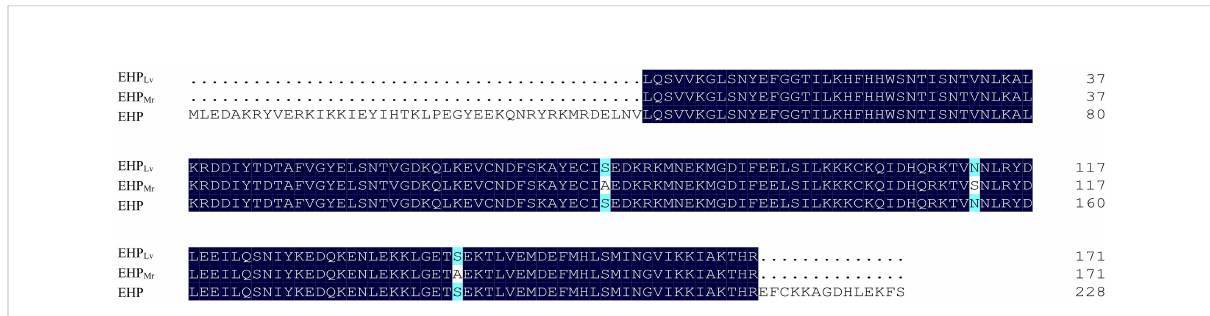
FIGURE 2 Alignment of partial protein sequences of the SWP1 from EHP Lv , EHP Mr , and reference EHP (GenPept accession nos. AVQ09707). The amino acids with white differ from the consensus. The numbers on the right indicate the amino acid position in the published